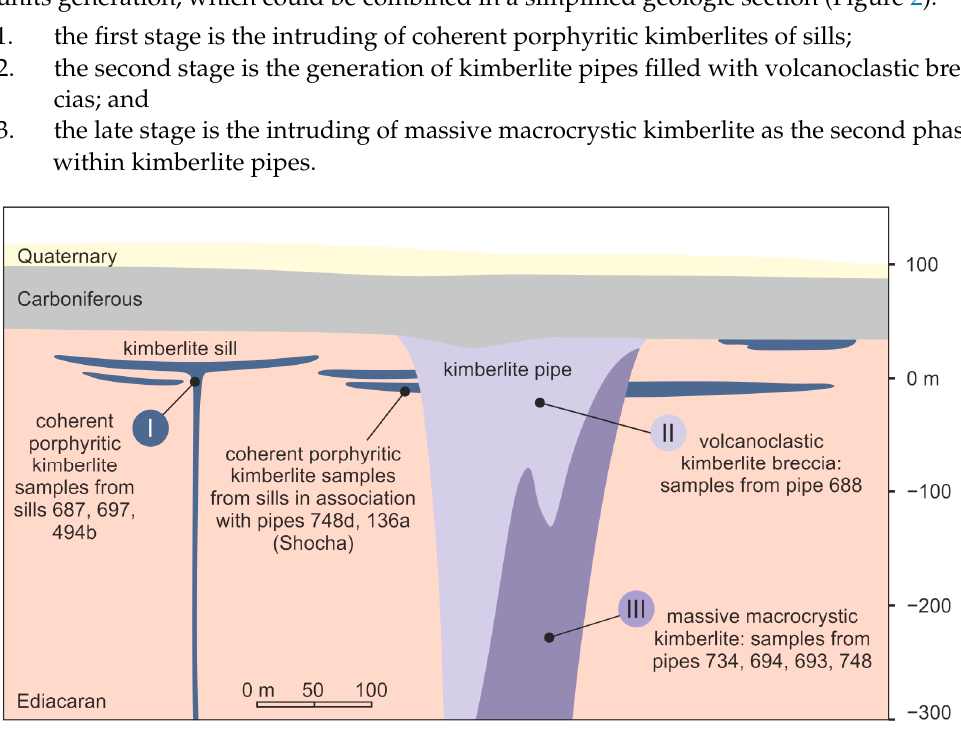
Figure 2. The simplified geological section of kimberlite magmatism of the Kepino cluster. The numbers are for kimberlite magmatism stages, according to Golovin N.N. [32].